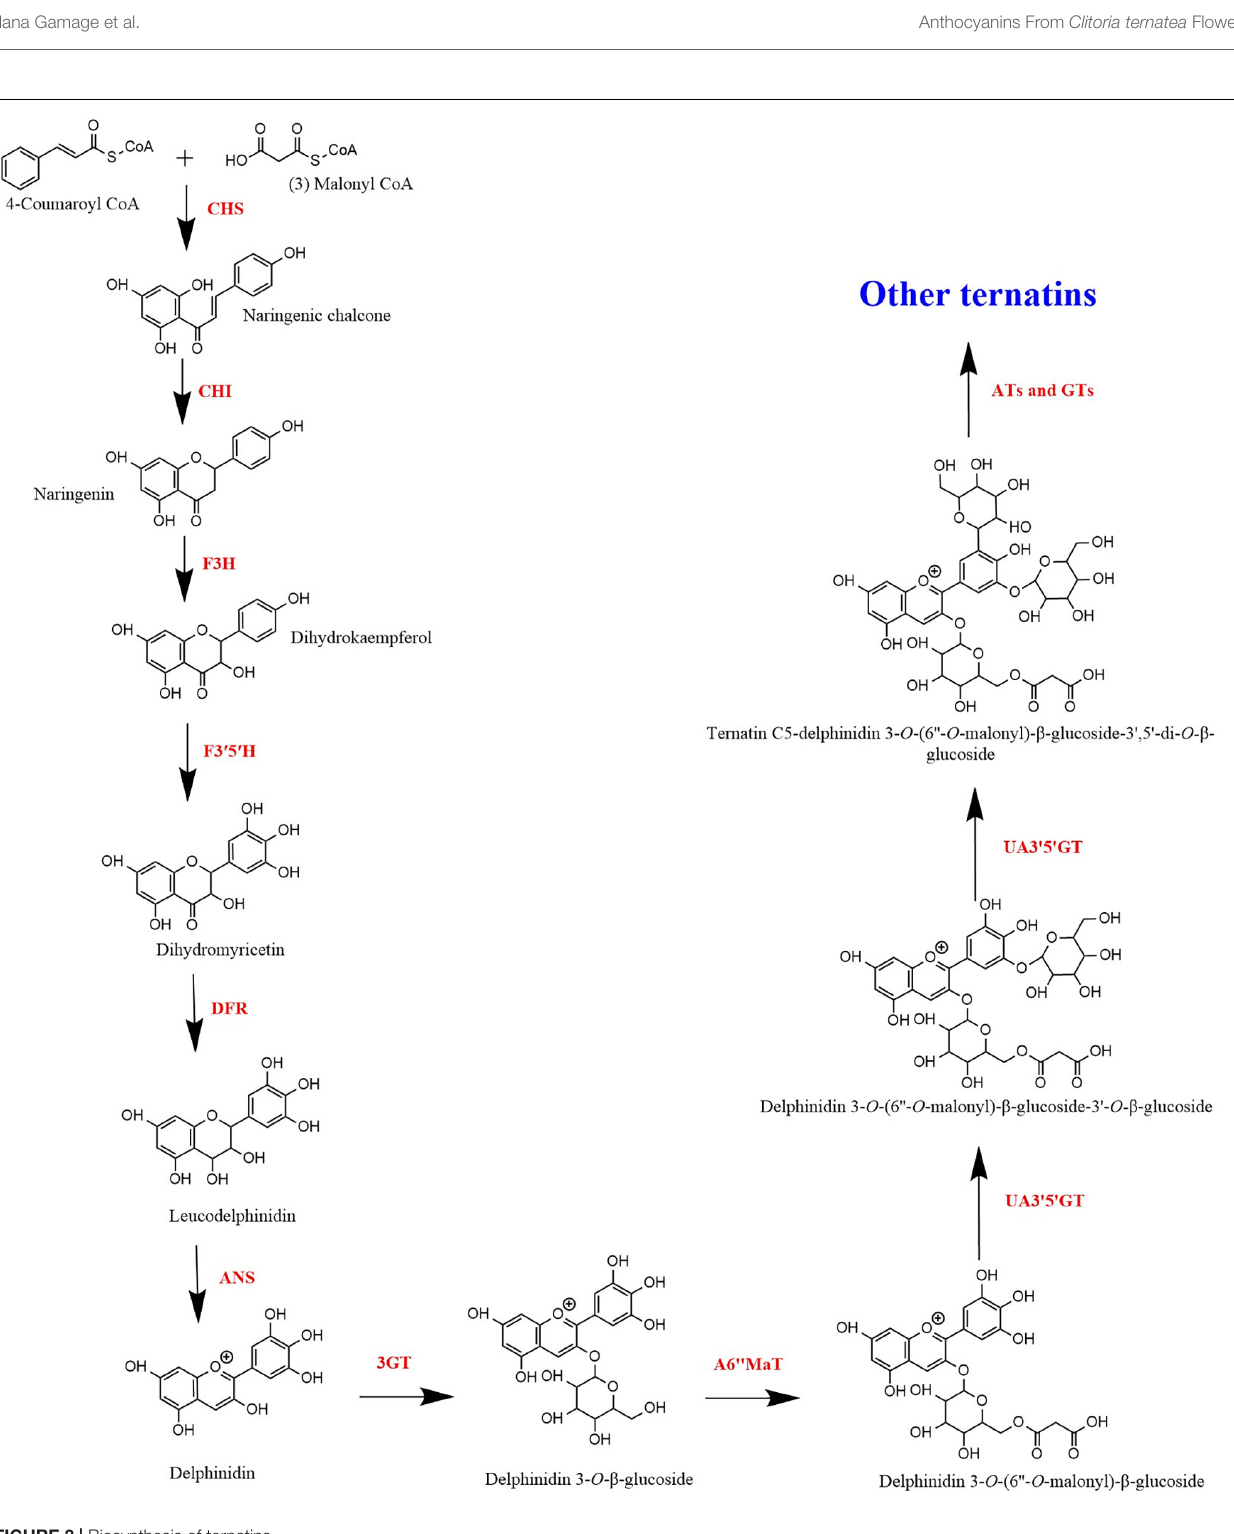
FIGURE 3 | Biosynthesis of